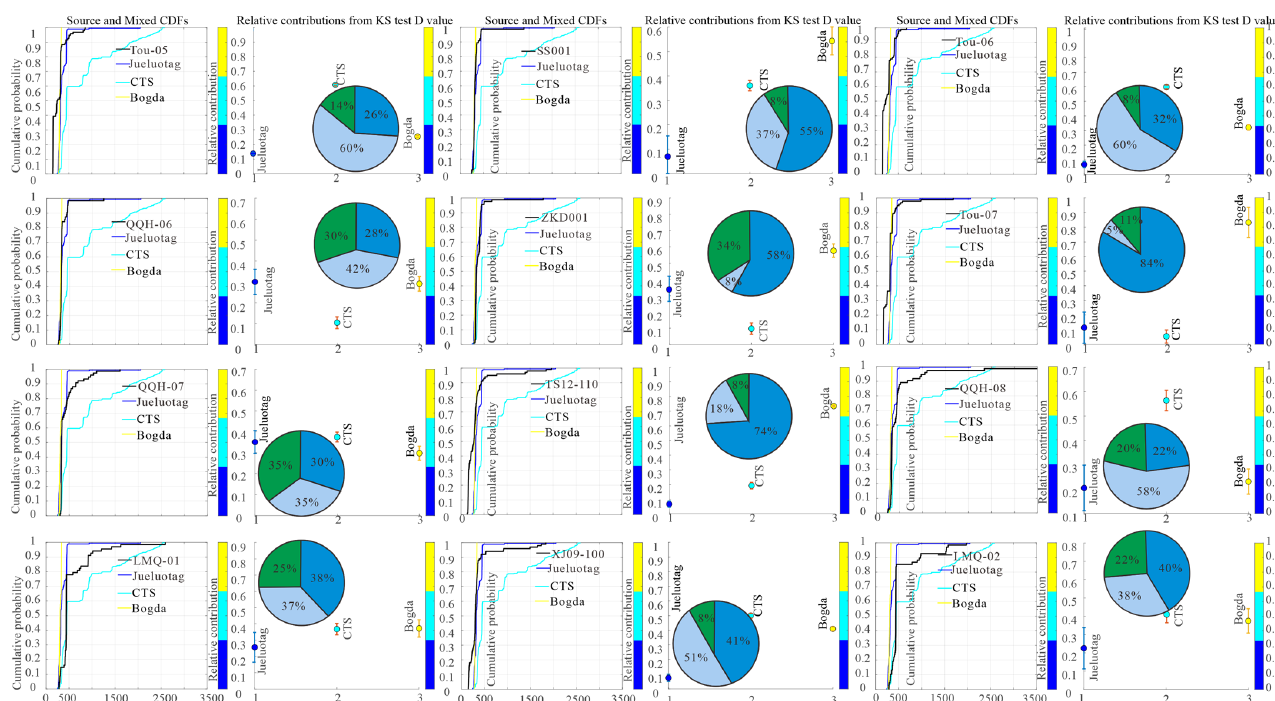
Figure 16. Decomposition model quantifying the U-Pb age distribution of detrital zircons from different source areas using DZ mixed modeling [8]; J2-3-3-Dzmix.